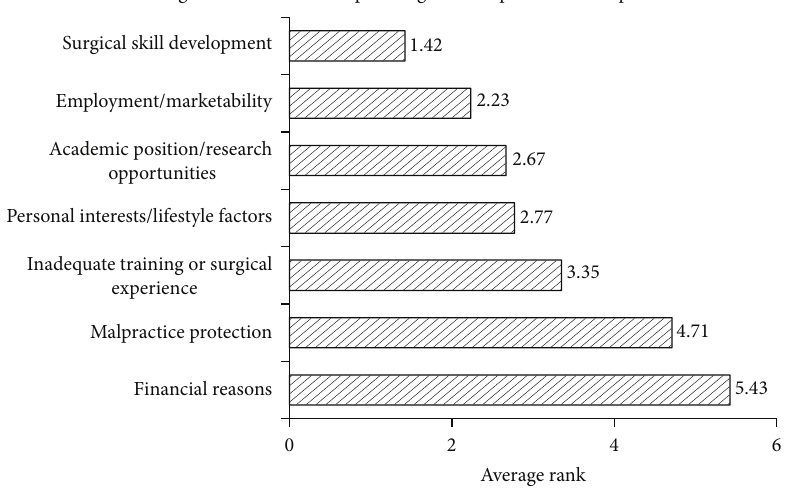
Figure 3: Average ranking of selected reasons for pursuing a fellowship. Horizontal bar-chart reporting the average rank in descending order of selected reasons among respondents for pursuing an orthopedic fellowship (a rank of 1 representing the highest priority and 7 representing the lowest